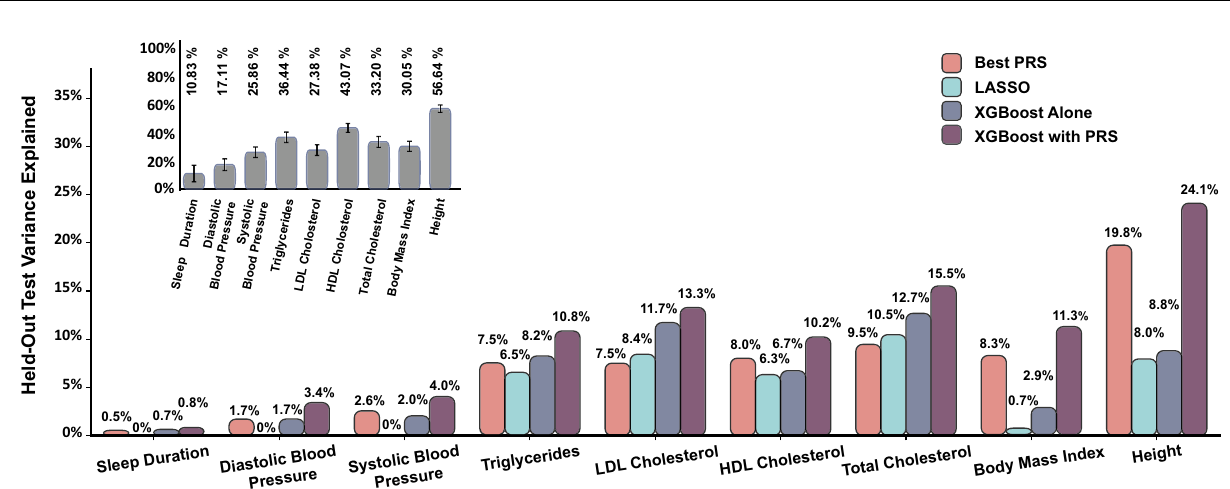
Fig. 3 Nonlinear model consistently outperforms linear ones for prediction of multiple complex phenotypes in multi-ethnic dataset. Linear (PRS-pink), linear-regularized (LASSO — teal), and nonlinear (XGBoost — gray, purple) models were employed to predict the harmonized phenotypes from SNP data from TOPMed following adjustment for covariates. Two versions of the XGBoost algorithm are shown with the fi rst model employing only the SNPs as features (gray; XGBoost alone) and a second model which had the PRS as one of the features as well (XGBoost with PRS). The LASSO algorithm (teal) was trained on the same set of SNPs as the XGBoost. The inset (gray) depicts estimated heritability for same phenotypes in the same database using the REML approach with error bars of 95% con fi dence intervals estimated through restricted maximum-likelihood